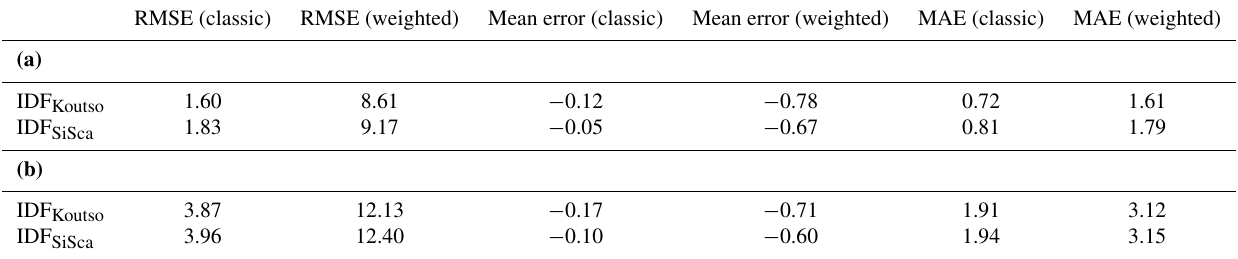
Table 1. Global quantile–quantile scores results for the different IDF models: (a) calibration mode and (b) validation mode. All scores are expressed in mm h − 1